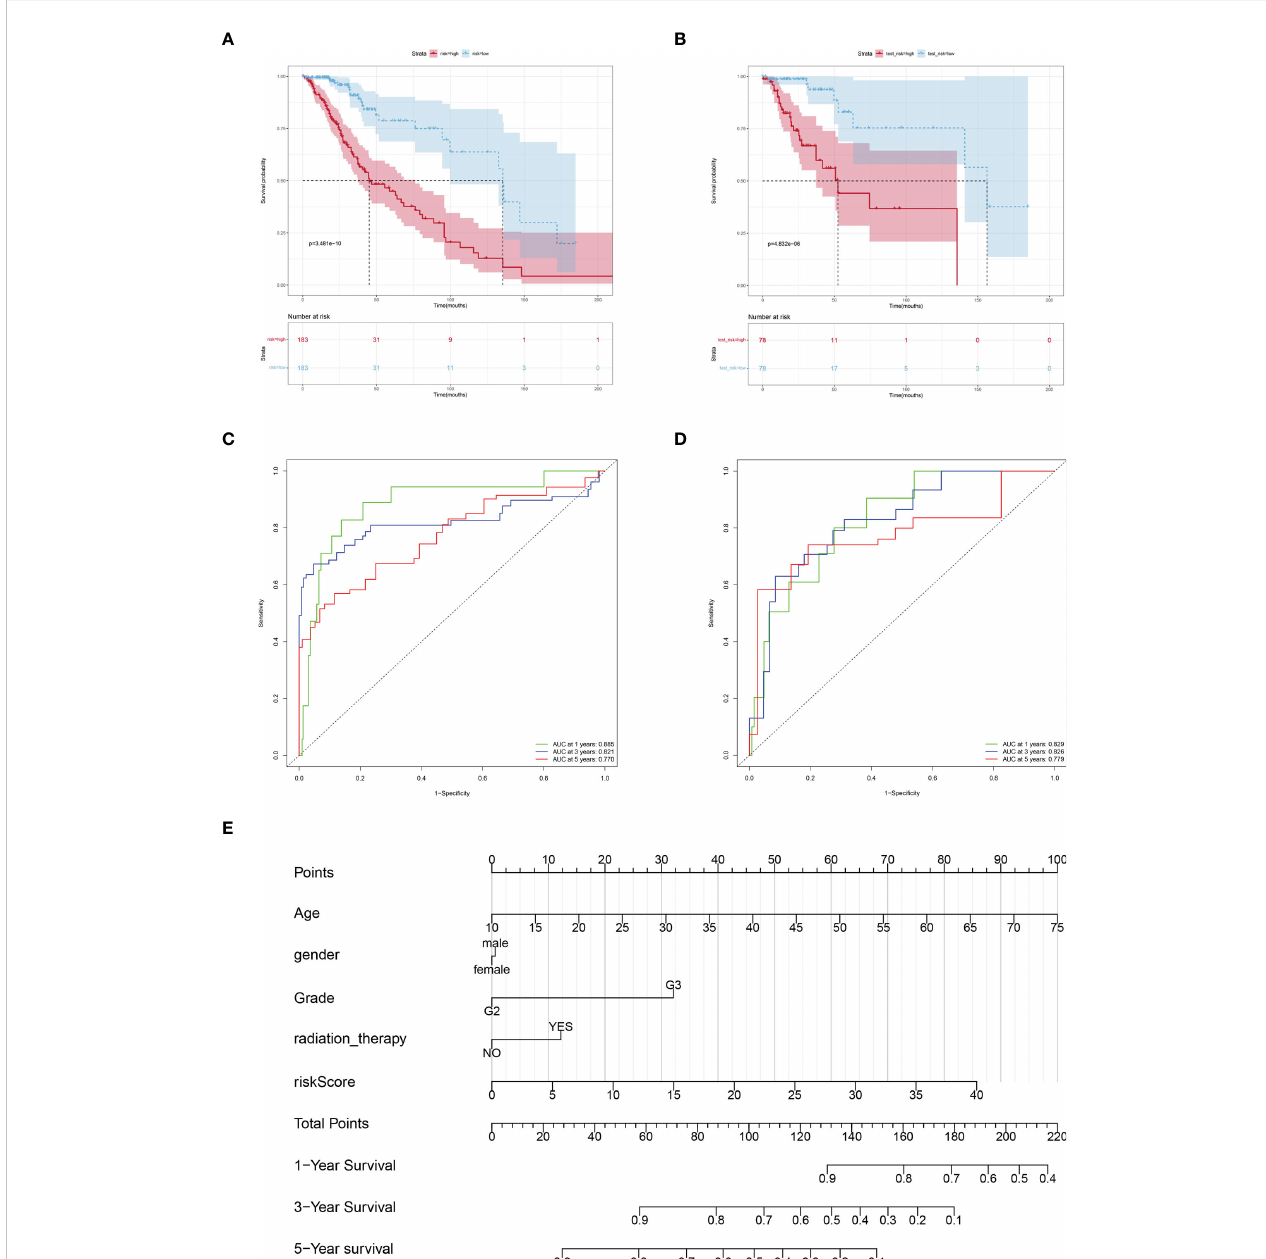
FIGURE 4 Veri fi cation the prognostic value of risk score. Kaplan-Meier curves of LGGs patients in the TCGA training cohort (A) and testing cohort (B) . AUC values at 1, 3, and 5 years in the TCGA training cohort (C) and testing cohort (D) . (E) Nomogram integrating risk score and clinical variables predicts 1-, 3-, and 5-year OS